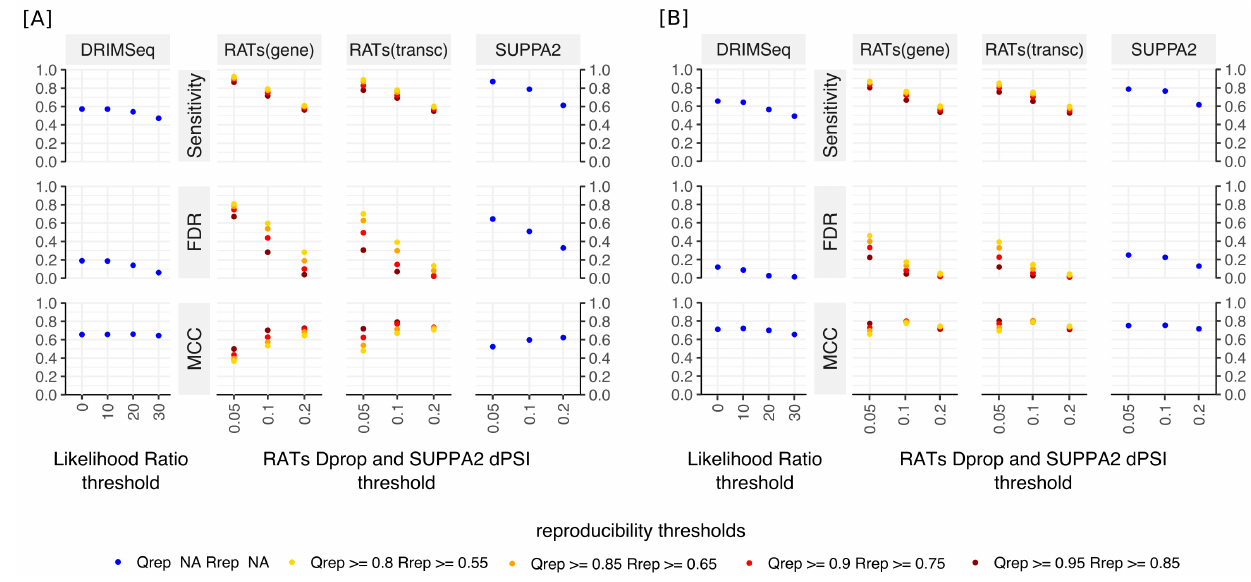
Figure 3. Performance comparison between RATs , SUPPA2 and DRIM-Seq . The performance was assessed on the human [ A ] and Drosophila [ B ] simulated datasets from ArrayExpress E-MTAB-3766 30 , over a range of threshold values for the effect size ( RATs - Dprop, SUPPA2 - dPSI, DRIM-Seq likelihood ratio - lr ) and confidence in the result ( RATs quantification reproducibility – Qrep, RATs inter-replicate reproducibility - Rrep ). The statistical significance cut-off was at 0.05 for all cases. The measures of performance are the sensitivity, false discovery rate (FDR) and Matthews correlation coefficient (MCC). The datasets were quantified using Salmon 0.9.2 and the metrics were calculated accounting only for the genes strictly listed in the “truth” sets. The results using Kallisto for the quantification are practically identical (see Extended data 2 33